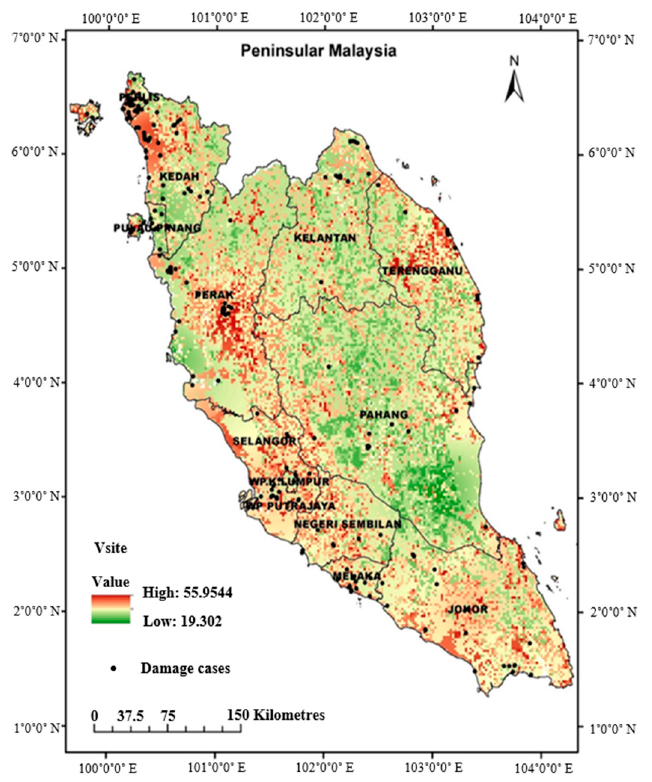
Figure 10. The V site wind hazard map of Peninsular Malaysia.